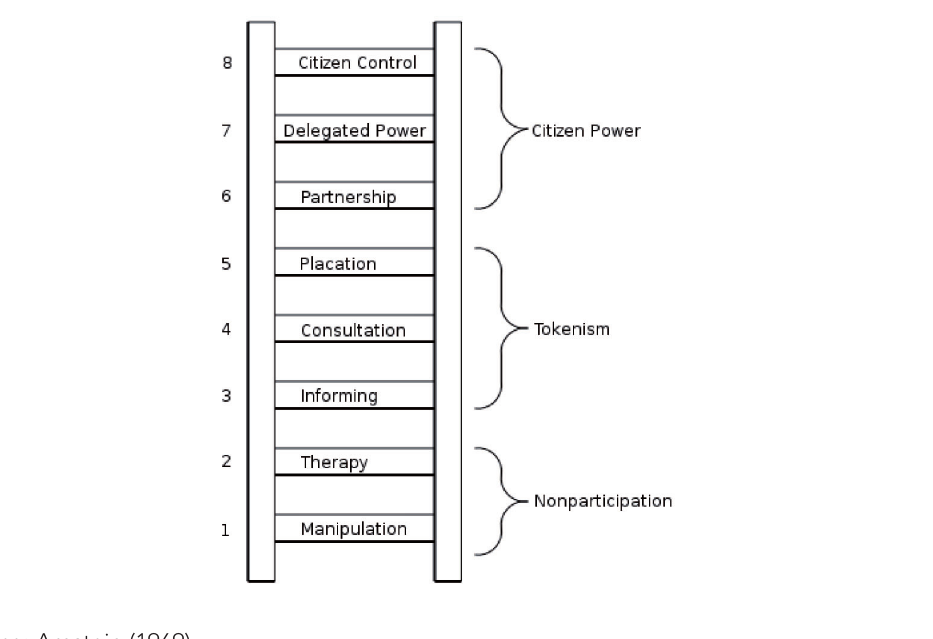
Figure 1: A ladder of citizen